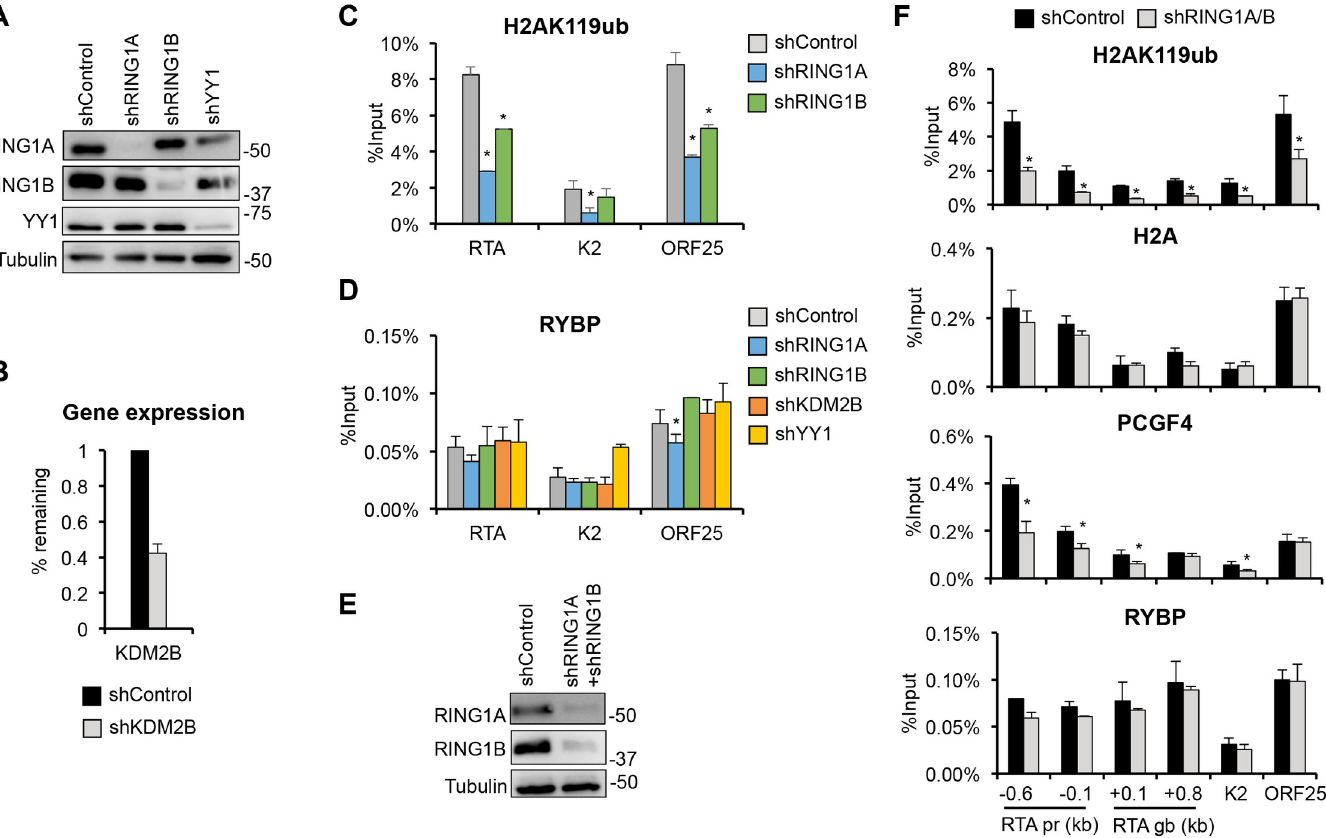
Fig 4. Testing the effect of PRC1 and PRC1-recruiting transcription factors on RYBP binding to KSHV promoters. (A-D) SLK cells were transduced with shControl, shRING1A, shRING1B, shKDM2B, and shYY1 lentiviruses for 72 hours followed by KSHV infection for 24 hours. (A) Immunoblot analysis to confirm the shRNA knockdown of RING1A, RING1B, and YY1 at the protein level. (B) Confirming the shRNA knockdown of KDM2B by RT-qPCR. The percentage of remaining RNA transcript level is shown relative to the shControl. (C) ChIP for H2AK119ub. (D) ChIP for RYBP. (E-F) SLK cells were co-transduced with shRING1A and shRING1B lentiviruses for 72 hours, followed by KSHV infection for 24 hours. (E) The shRNA knockdown of RING1A/B was confirmed by immunoblot. (F) ChIP for the indicated factors on viral promoters and RTA gene body. The t-test was performed between shControl and shRING1A, shRING1B, shKDM2B, shYY1 and between shControl and shRING1A/B where p < 0.05 ( � ) was considered statistically